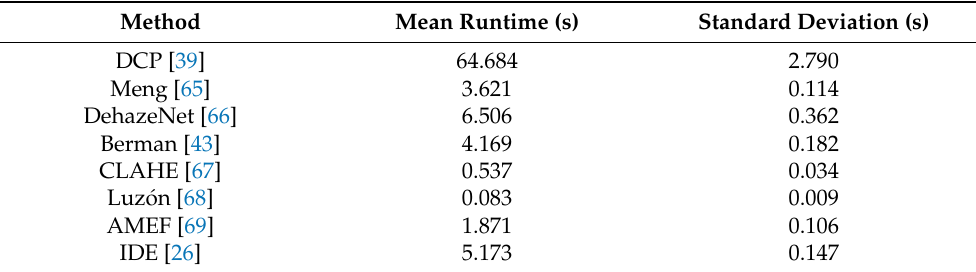
Table 2. Mean processing time and standard deviation for 50 runs of each dehazing method with RGB images of 1312 × 1082 pixels for each selected dehazing method.